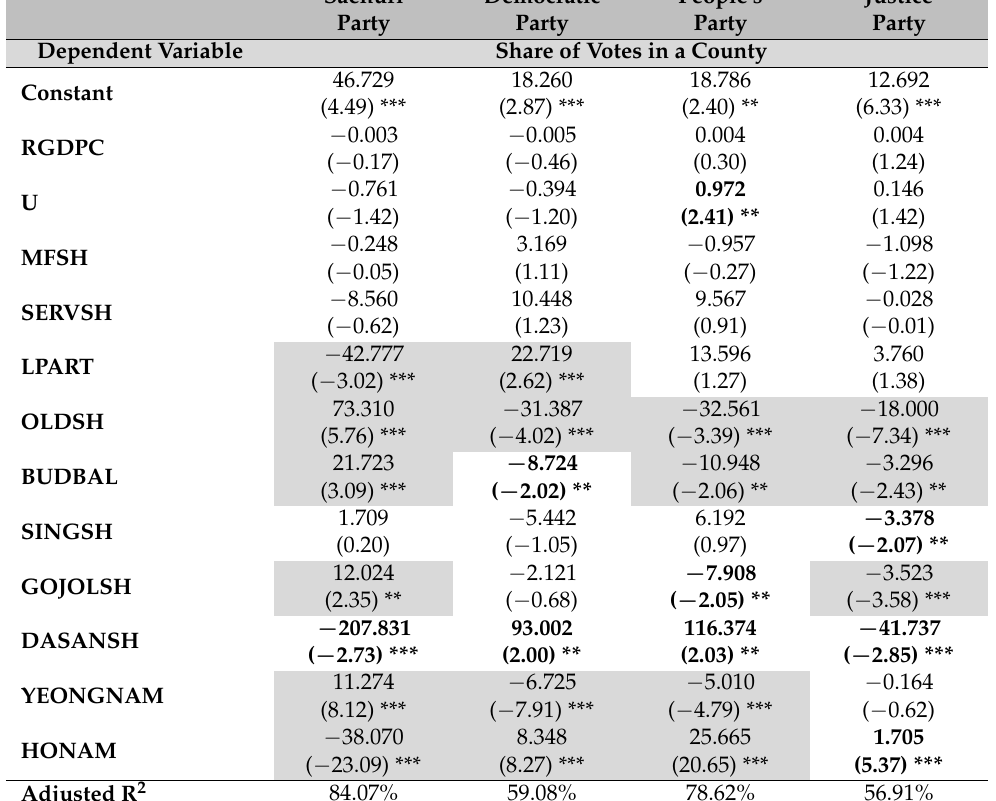
Saenuri Democratic People’s Party Party